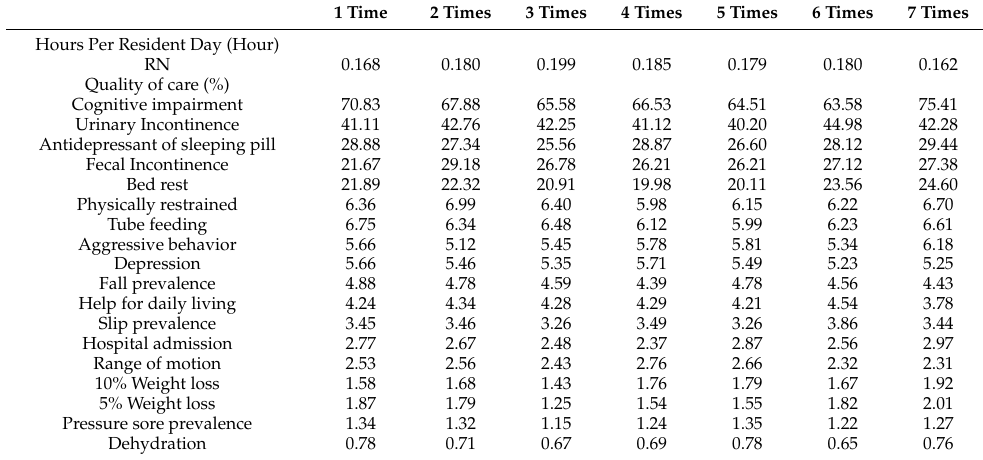
Table 2. Change of RN HPRD and Quality of Care Outcome According to Each Survey Point (7 Times).